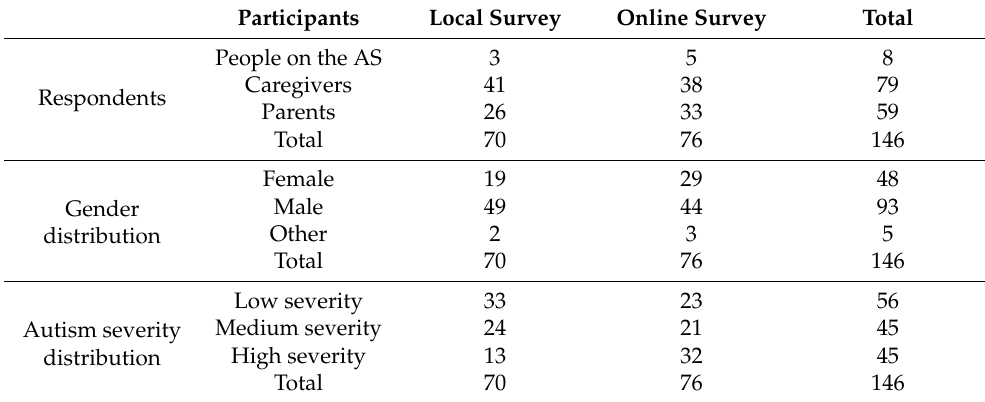
Table 3. Overview of participants from the questionnaire on environmental domains.